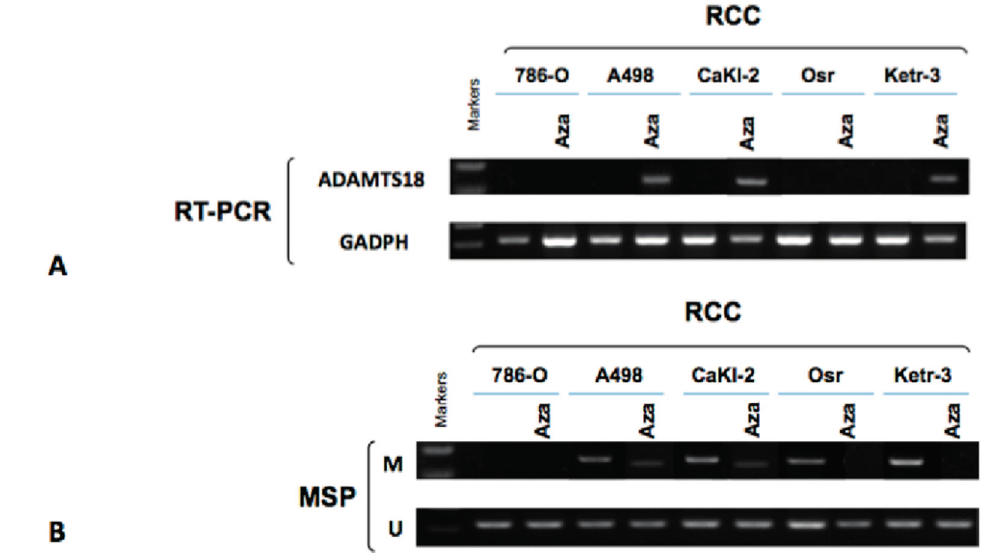
Figure 2. Analysis of the ADAMTS18 gene in ccRCC-derived cell lines after drug treatment. ( A ) ADAMTS18 gene expression was restored in the ccRCC-derived cell lines by 5-AzaC treatment, as observed by RT-PCR; GAPDH served as the control; and ( B ) The ADAMTS18 gene was partially or completely demethylated in some of the ccRCC-derived cell lines by MSP. M, methylated; U,